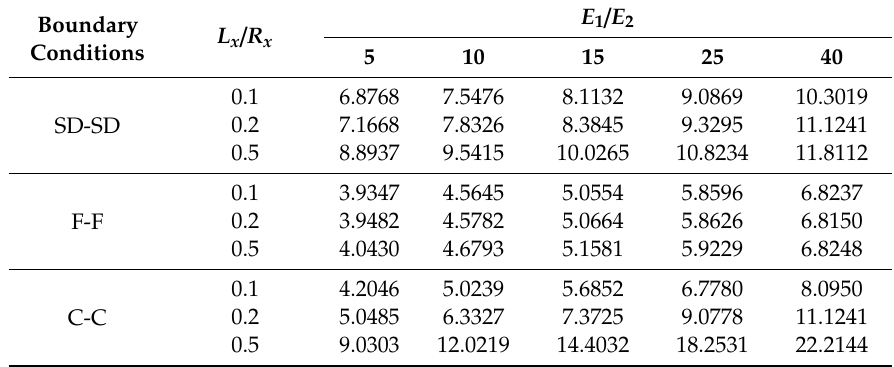
Table 10. The fundamental frequency parameter Ω for composite shallow [0 ◦ / 90 ◦ ] spherical shells for variety length to radius ratios L x / R x , modulus ratios E 1 / E 2 , and boundary conditions by FSDT.